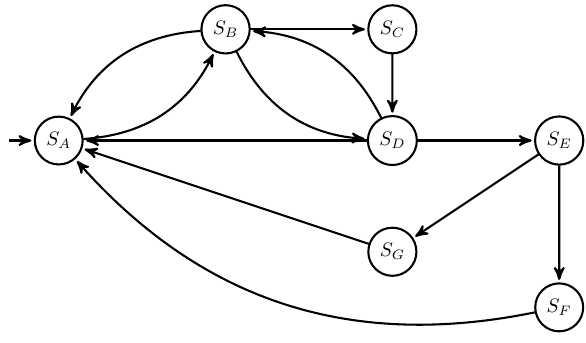
Figure 2. A finite state machine representing the